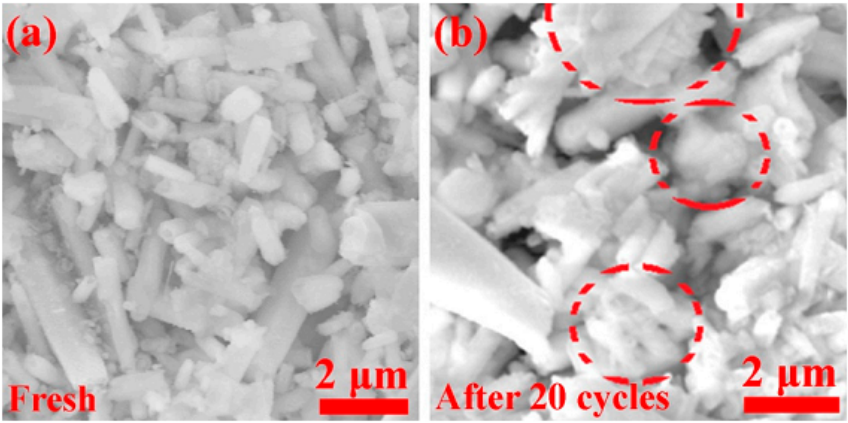
Figure 6. SEMimagesoftheZnO@ZnSnanorodelectrodes( a )beforeand( b